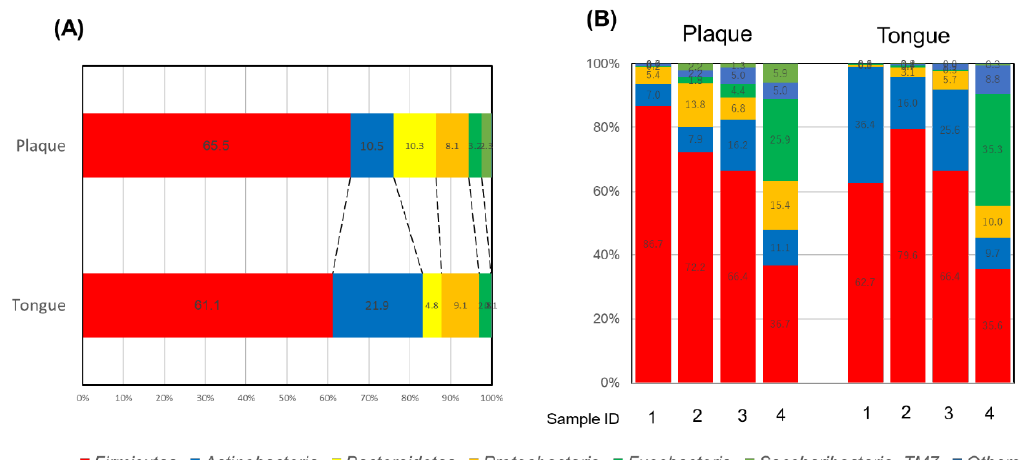
Figure 1. Proportion of phyla in denture plaque and the tongue: ( A ) total, and ( B ) individual subjects.